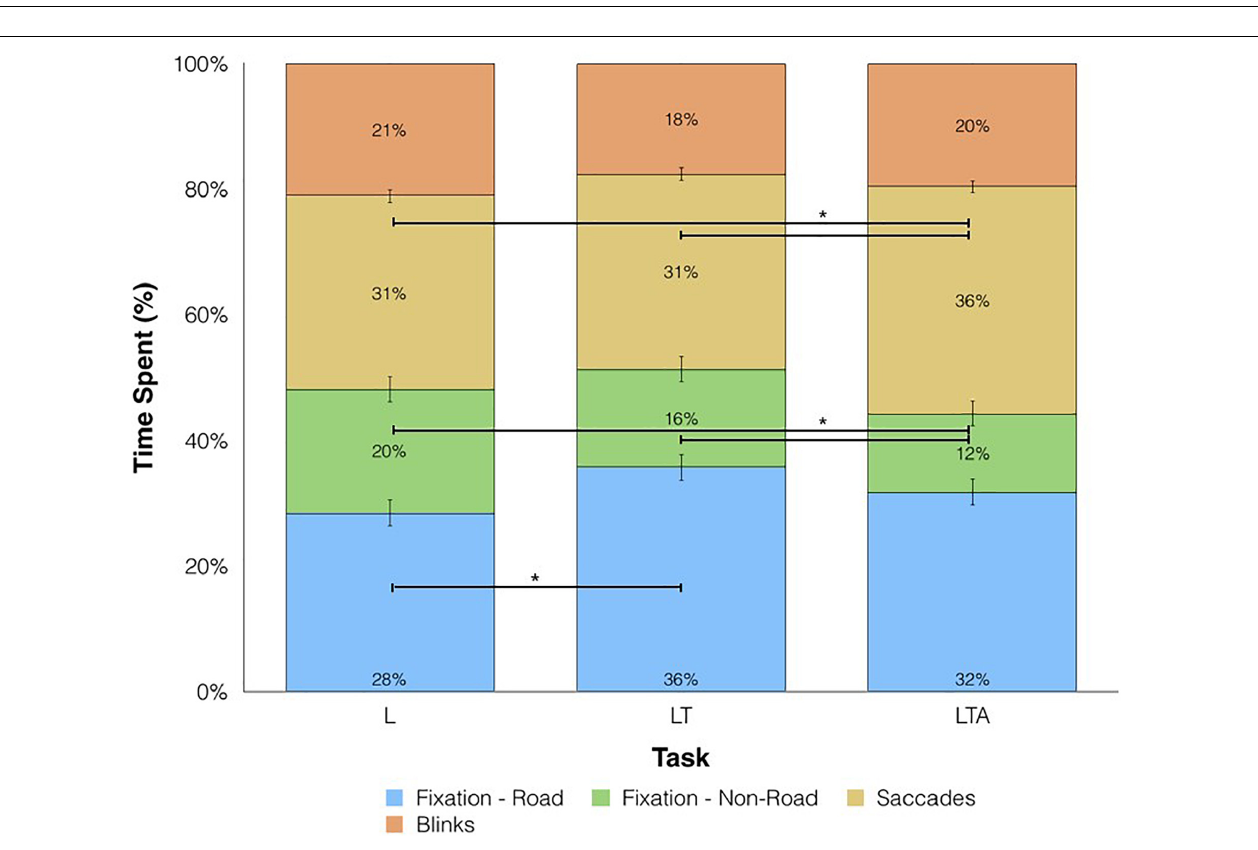
FIGURE 5 | Distribution of gaze in the various tasks, averaged over all participants. Maps of percent fixation duration were computed as described in the text, and are shown as contour lines overlaid on the driving simulation screen. (A) L, left turn condition; (B) LT, left turn with traffic condition; and (C) LTA, left turns with traffic and auditory distraction.